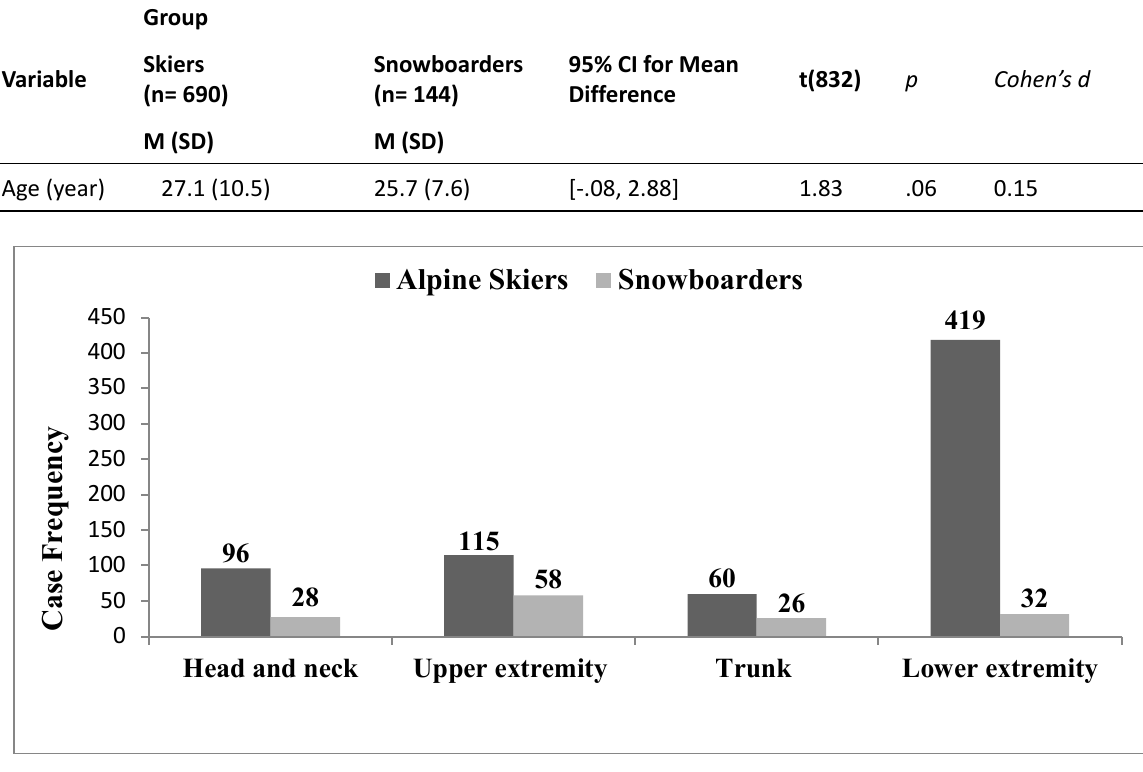
Figure 3. Injury frequency distribution for alpine skiers and snowboarders according to the body region. (Note: *; p <